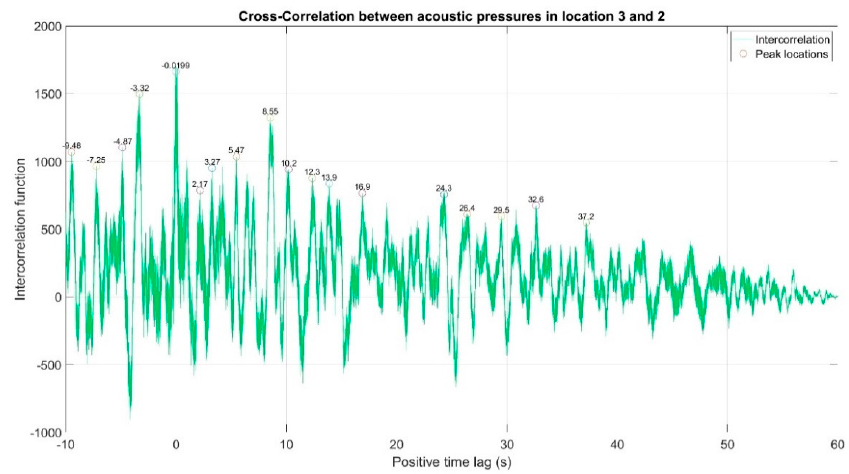
Figure 15. Inter-correlation between acoustic pressures in location 3 and 2. There are several peaks for positive lag. The highest correlation is for lag of − 0.02 s.